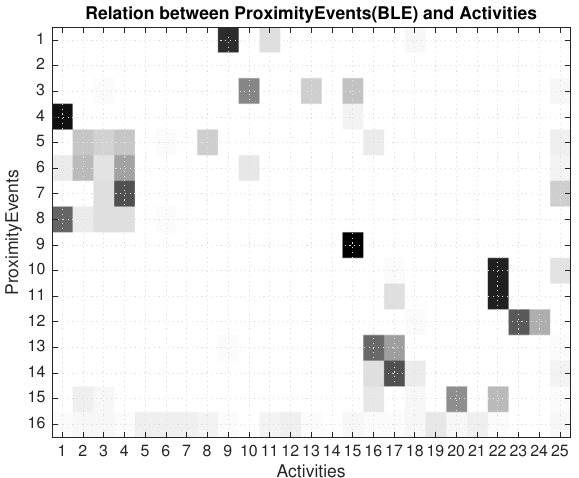
Figure 5. Measurement matrix relating proximity-BLE events with activities (for 7-days training